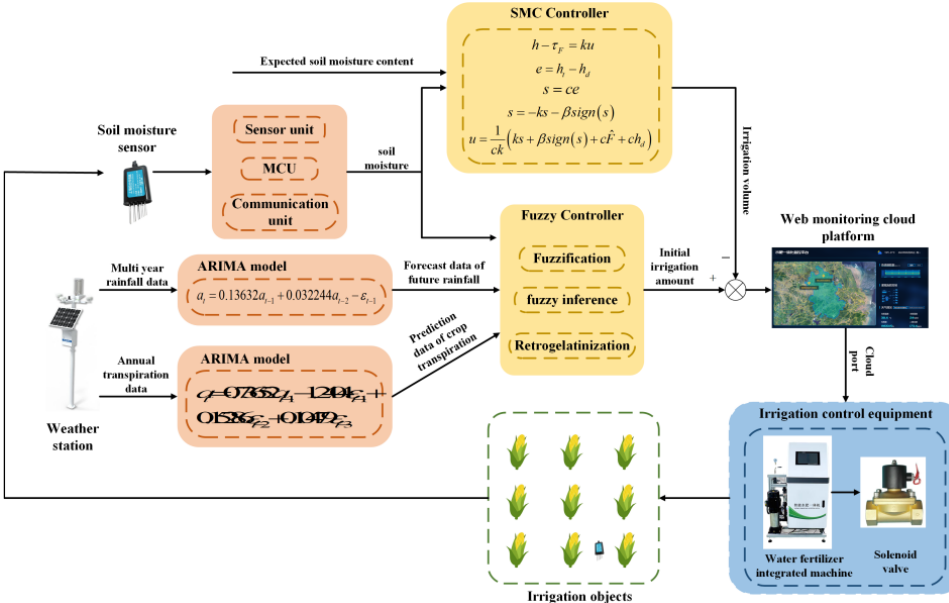
Figure 2. Intelligent irrigation control method.